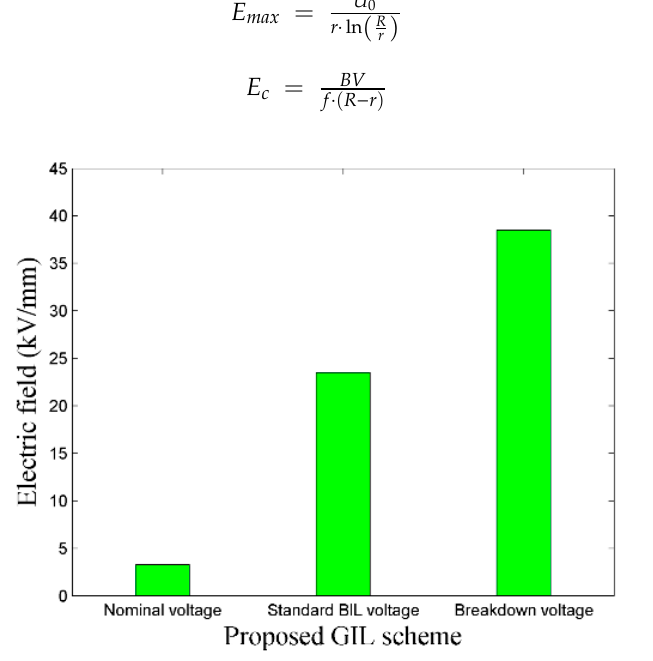
Figure 15. Electric field appraisal for the proposed FGIL scheme regarding operational, standard BIL, and breakdown